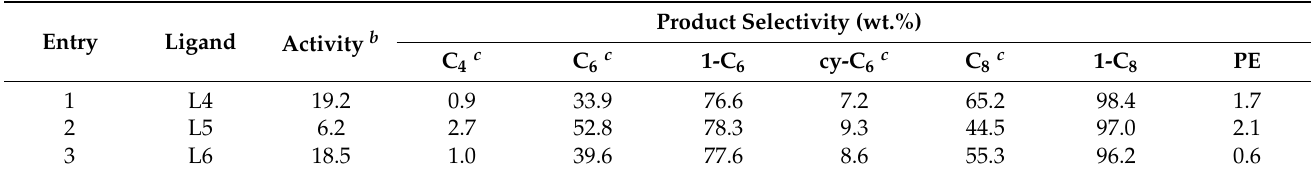
Table 2. Evaluation of L4–L6 ligands for selective ethylene oligomerization a